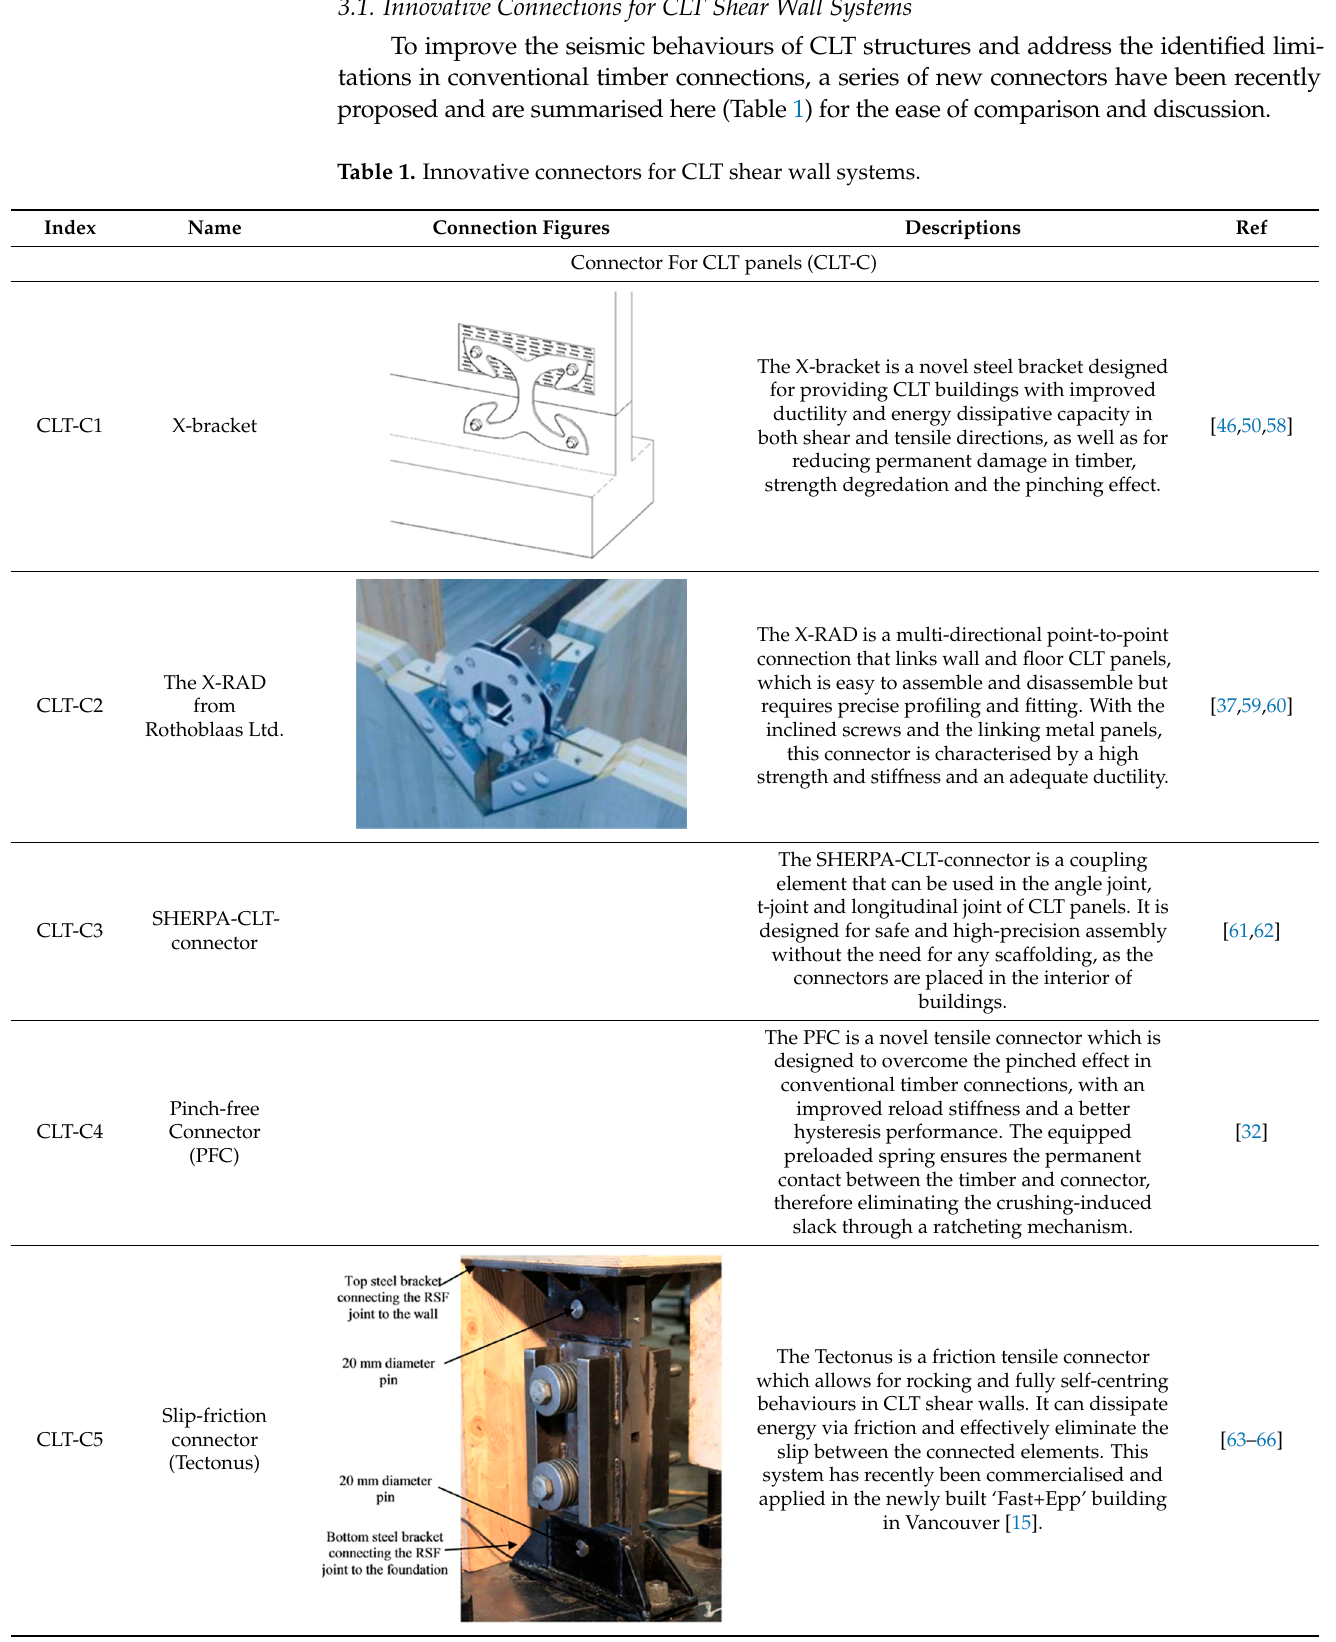
Table 1. Innovative connectors for CLT shear wall